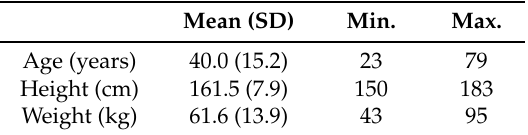
Table 1. Arthropometric data of the study participants.